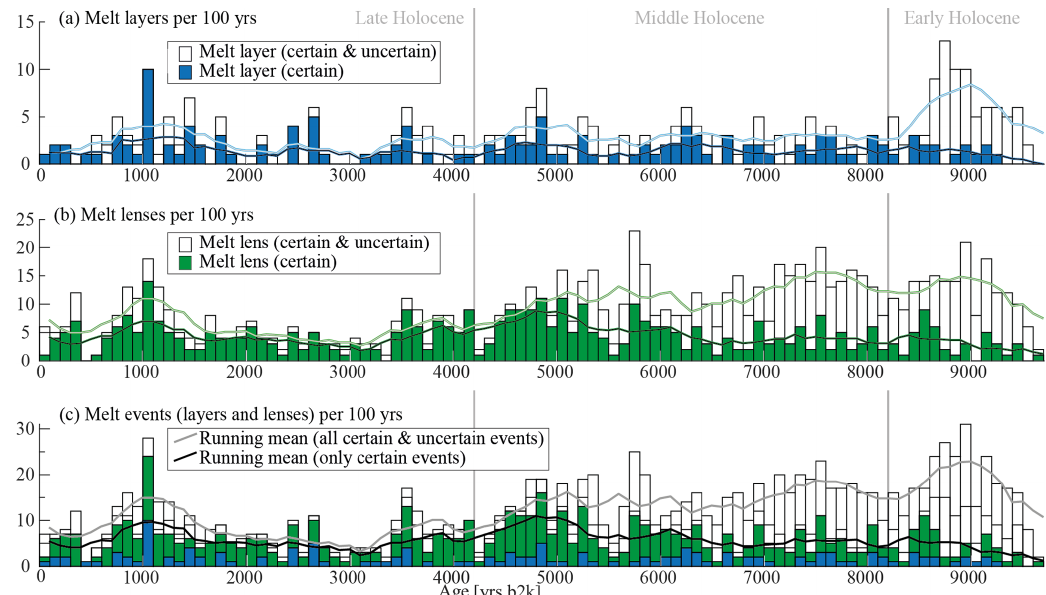
Figure 5. Number of melt layers and lenses per century throughout the last 9700 years in the EastGRIP ice core. Running means are shown as solid lines. (a) Melt layers (dark blue) and uncertain melt layers (white). (b) Melt lenses (dark green) and uncertain melt lenses (white). (c) Melt events, i.e., panels (a) and (b) stacked, including their uncertainties. Note that the bar representing the period from 0 to 100 years b2k represents only 56 years, not 100 years like the other bars, as our analysis begins in 1956CE.